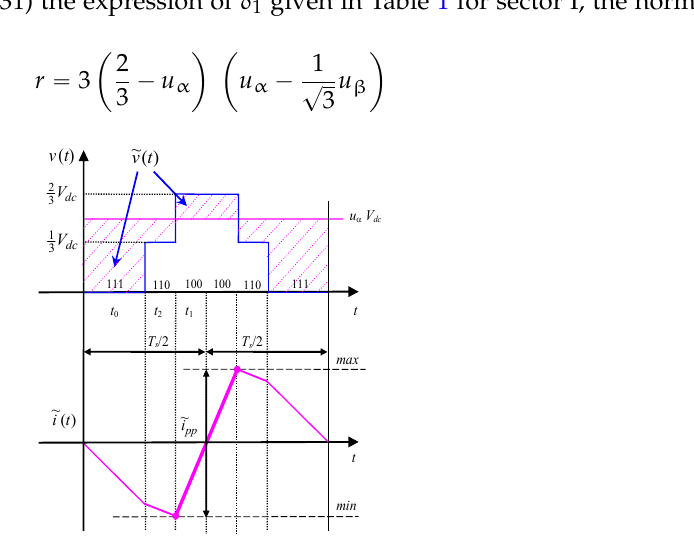
Figure 10. Output voltage and current ripple for DPWM+ technique in one switching period (sector I, u α ≥ 1/3).